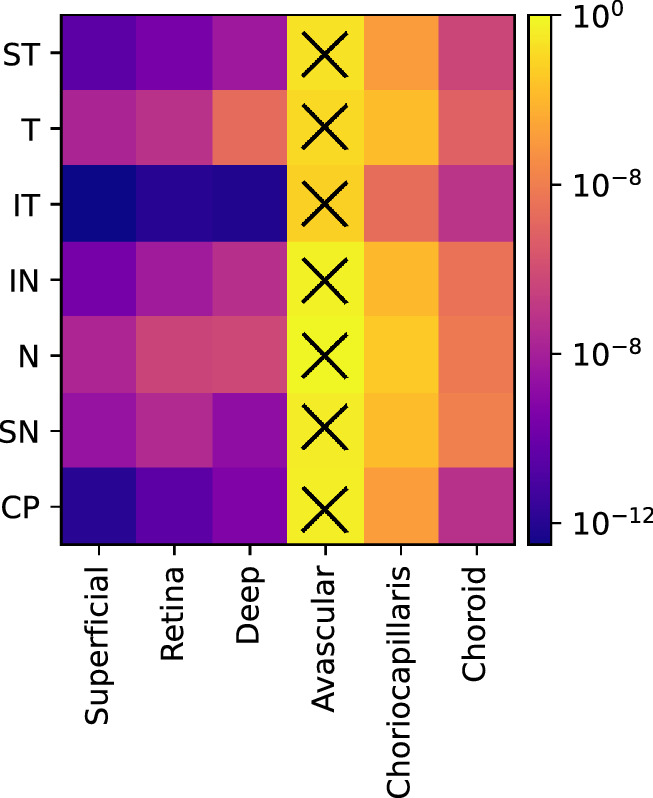
Mann-Whitney test, p value, for each vascular feature between control and glaucoma subjects. The X symbol denotes the groups that did not present a statistically significant difference (P >0.05).